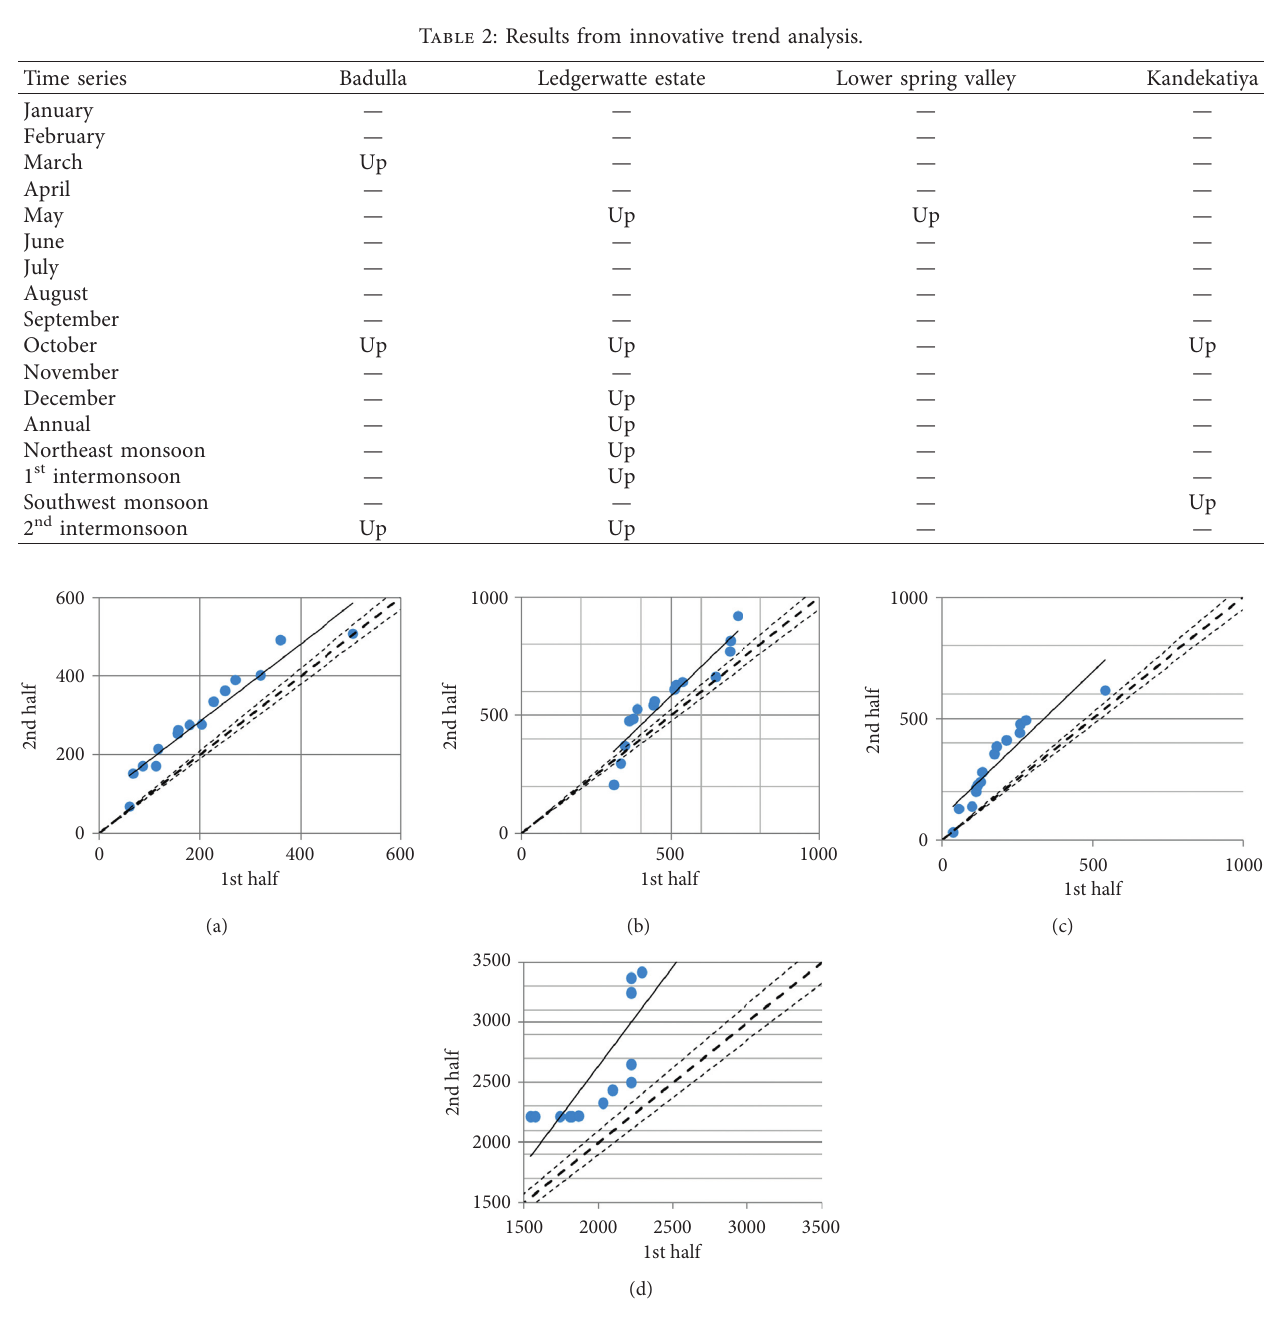
Figure 3: Graphical trend analysis results from ITA: (a) for Badulla–October; (b) for Badulla–2 nd intermonsoon; (c) for Ledgerwatte Estate–October; (d) for Ledgerwatte